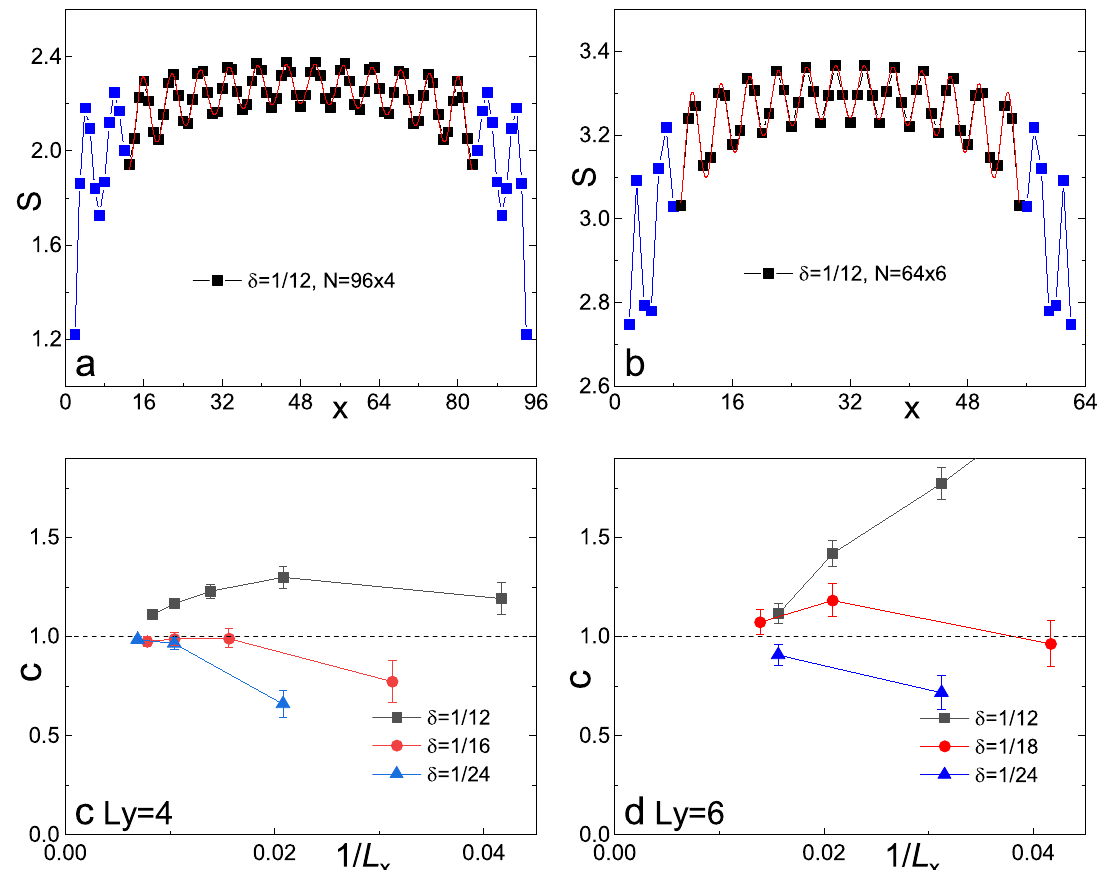
Fig. 6 Entanglement entropy S and central charge c . S is shown at doping level δ = 1/12 for ( a ) L y = 4 and ( b ) L y = 6 cylinders. Extracted central charge c using Eq. (5) for ( c ) L y = 4 and ( d ) L y = 6 cylinders a a function of L x and δ . Note that a few data points in blue from each end are removed to minimize boundary effects. Error bars denote the numerical